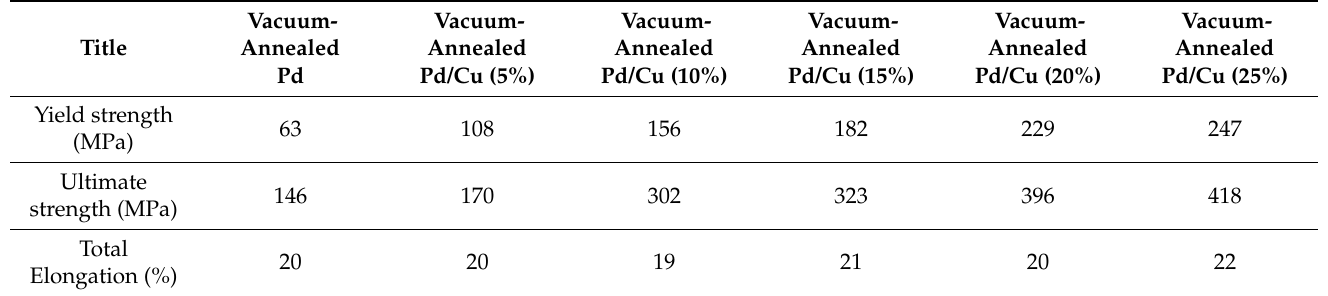
Table 1. Yield strength, ultimate strength, and total elongation for vacuum-annealed Palladium and Palladium–Copper Alloys.